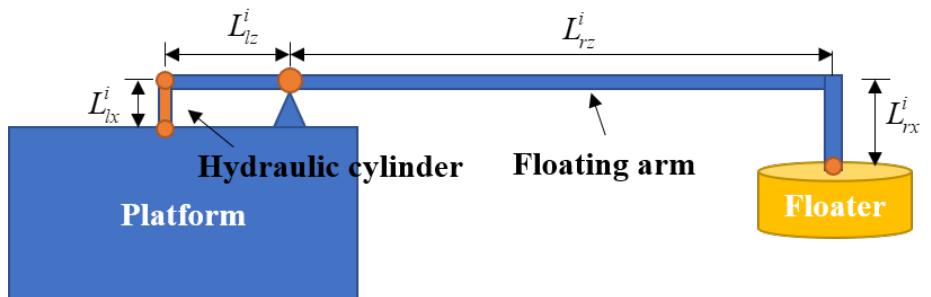
Figure 2. Sketch of the connection relationship of the platform, hydraulic cylinder, and